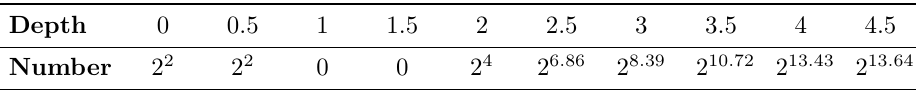
Table 5: Number of balanced Boolean functions with respect to expression